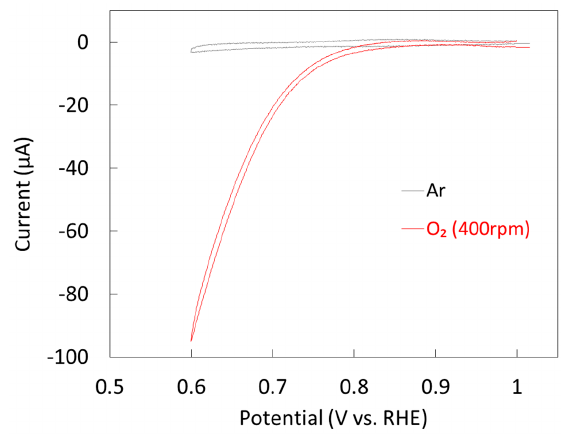
Figure 6. ORR activity measurement voltammogram for original Co-Pt Bronze.